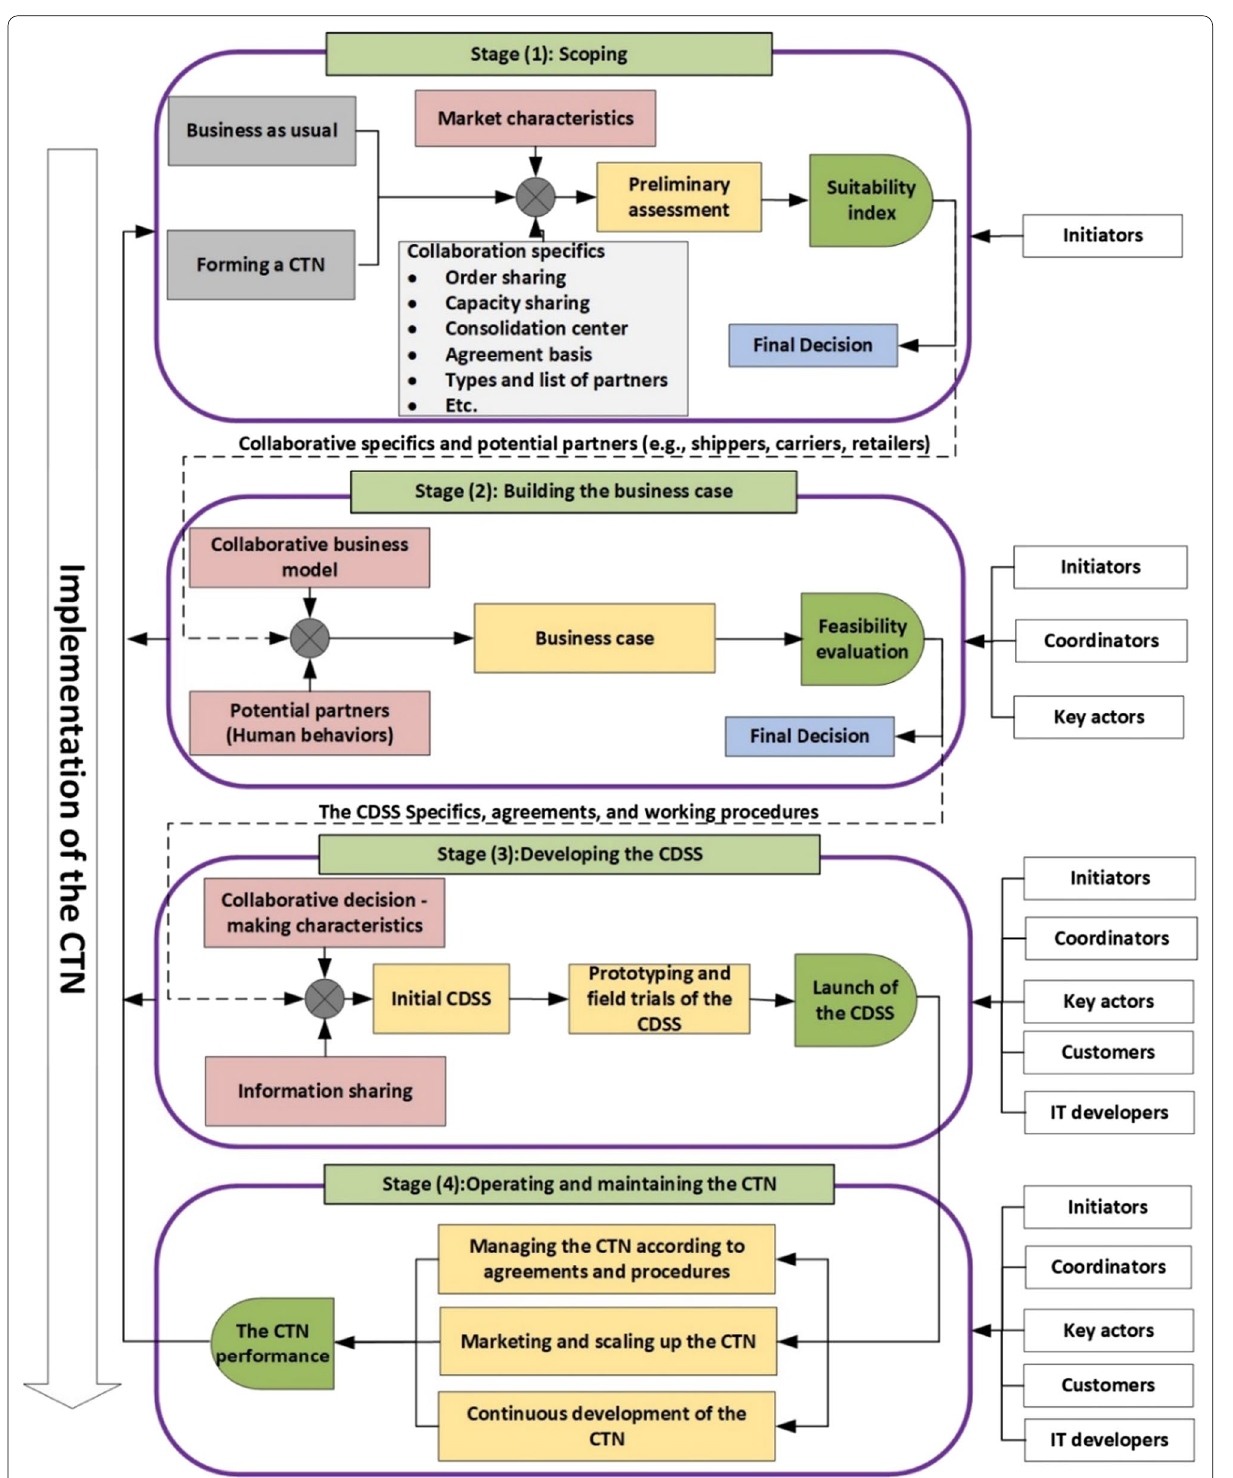
Fig. 5 A stage-gate model for the CTN implementation decision-making